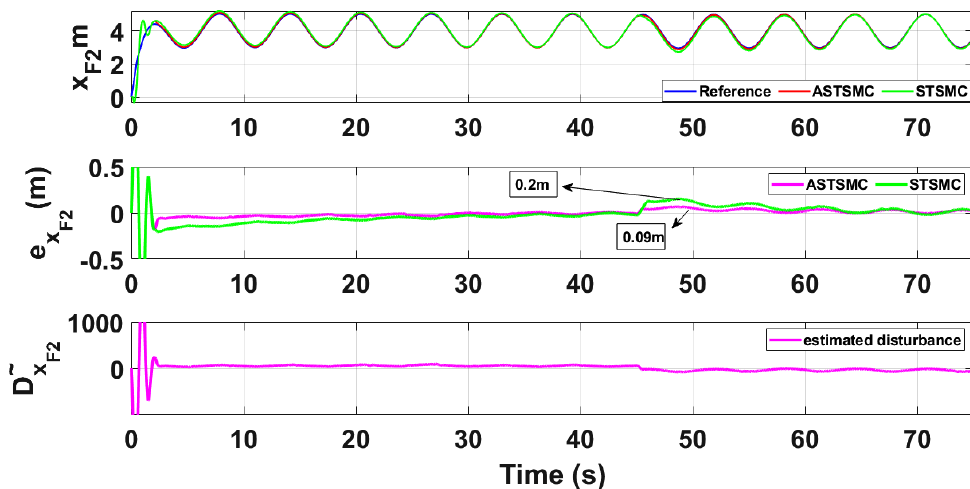
Figure 13. X F 2 tracking comparison under wind disturbance.